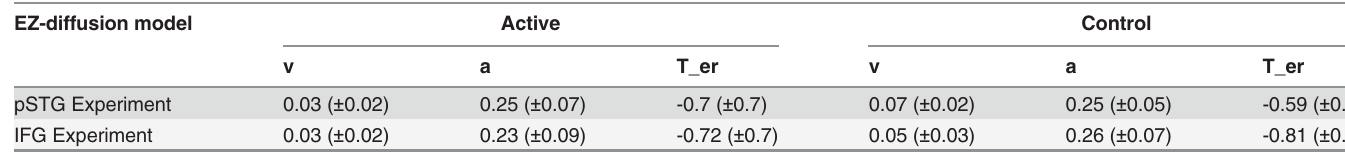
Table 2. Descriptive statistics for the diffusion model parameters.